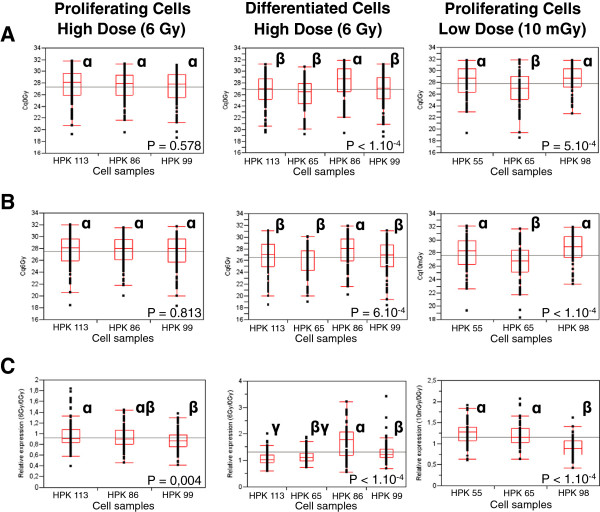
Global analysis of miRNA-Cq distribution and relative expression after irradiation in the different HPK samples (All-paired Tukey-Kramer tests). Each point represents a miRNA Cq in non-irradiated (A) or irradiated (B) state, or miRNA relative expression (irradiated vs non-irradiated) (C). Box & whiskers plots represent first decile, first quartile, medium, third quartile and ninths decile of data in each cell samples. The black line corresponds to the mean Cq for all samples. Greek letters besides box plots indicate differences between means: same letters-donors indicate no difference between means, different letters-donors indicate significant difference of means, double letters-donors indicate no difference with single letters.